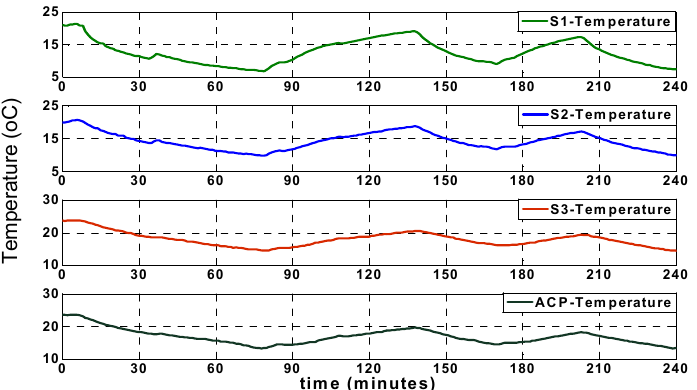
Figure 5. Actual temperature of reefer unit and sensor nodes.